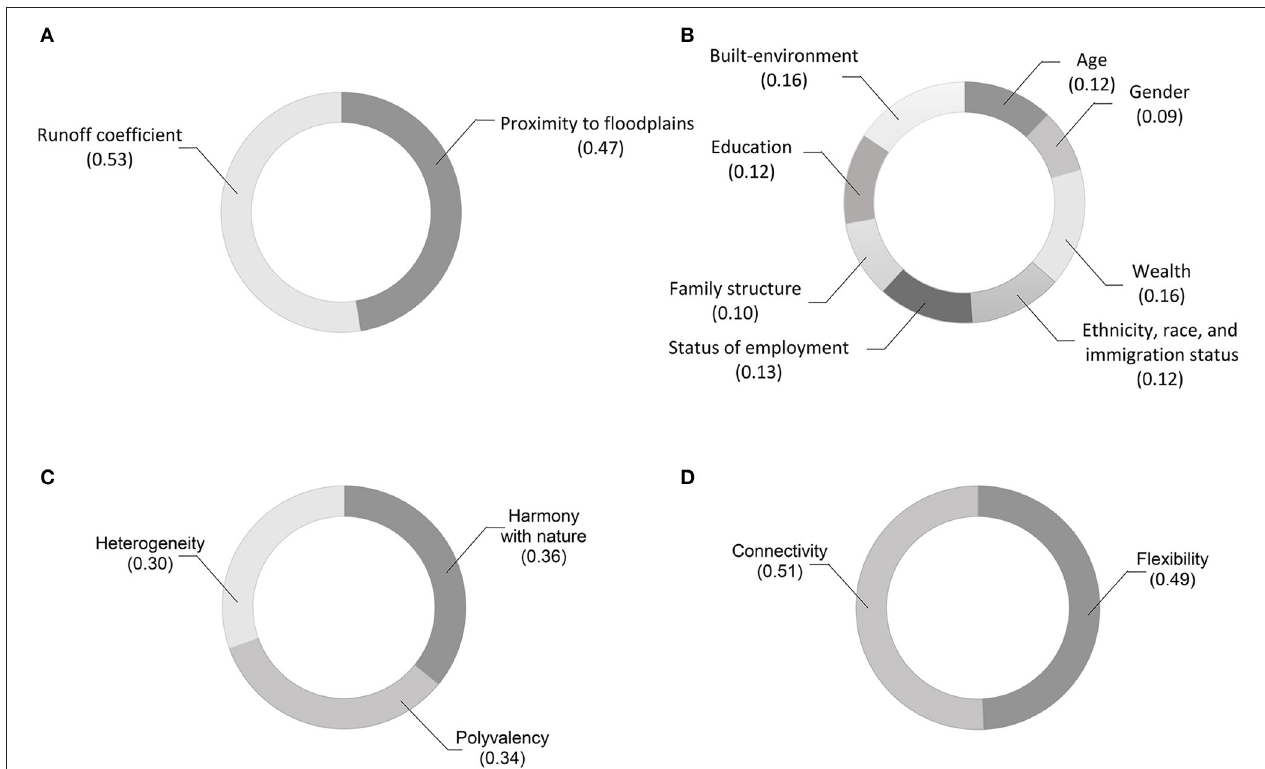
FIGURE 4 | The average weights of risk drivers’ indicators. (A) The average weights of flood exposure indicators. (B) The average weights of vulnerability indicators. (C) The average weights of indicators associated with the adaptive capacity of land uses. (D) The average weights of indicators associated with the adaptive capacity of town